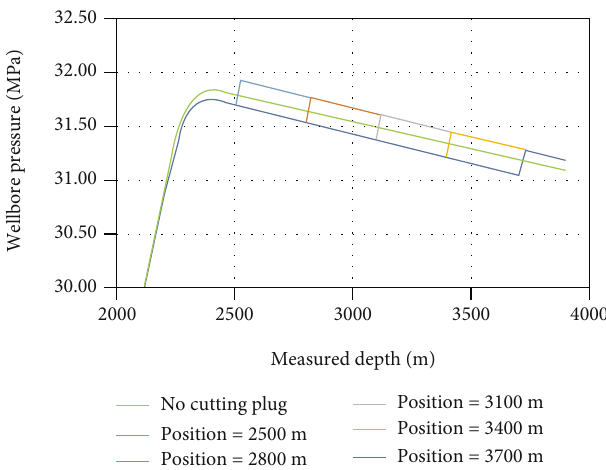
Figure 15: The e ff ect of cutting plug position on the wellbore pressures in an open pipe